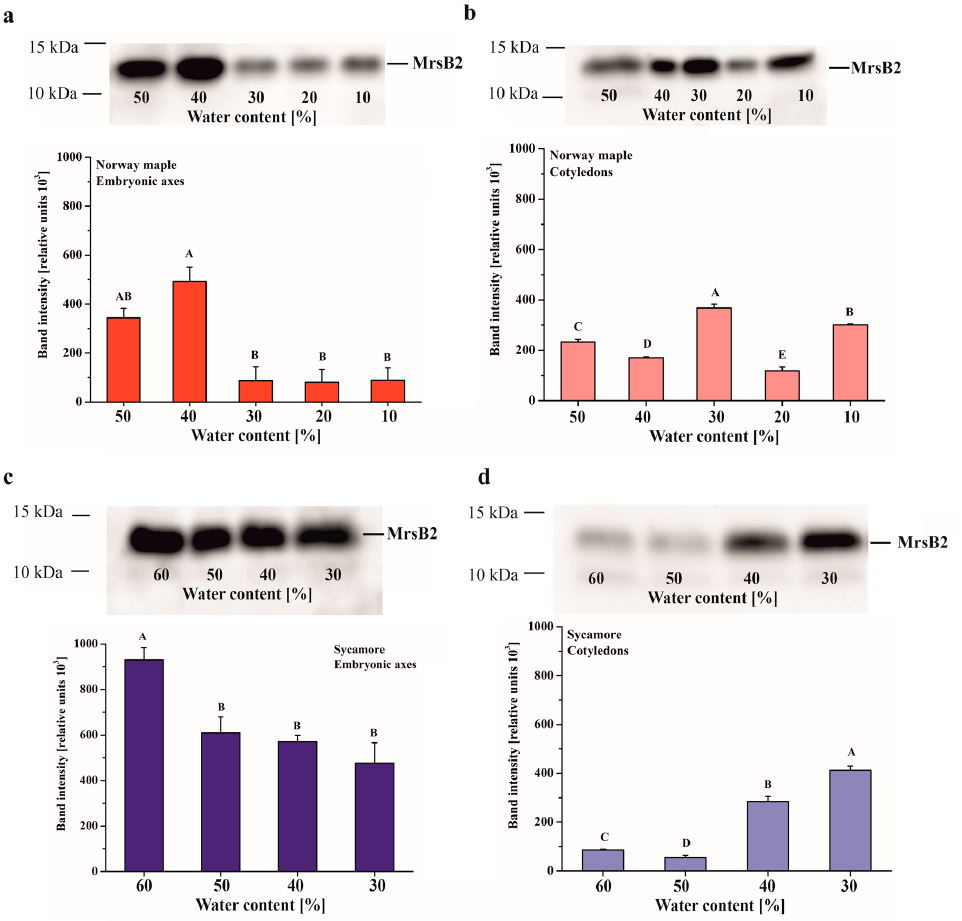
Figure 4. Immunoblot analyses and densitometric analysis of MsrB2 proteins in the embryonic axes ( a , c ) and cotyledons ( b , d ) of Norway maple ( a , b ) and sycamore ( c , d ). The data are the means of three independent replicates ± the STDs. The same letters indicate groups that are not significantly different according to Tukey’s test.